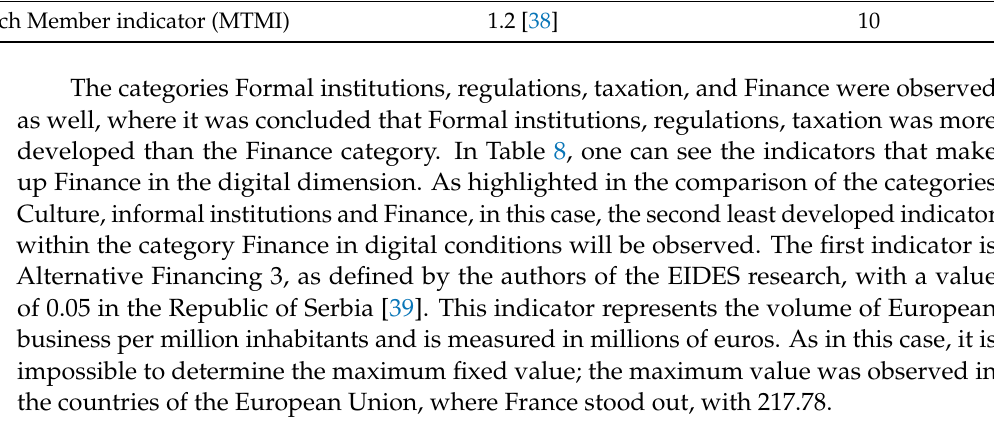
Table 8. The components of Finance in the digital dimension—the startup phase of an enterprise (the table refers to the Republic of Serbia and was made in the likeness of the EIDES